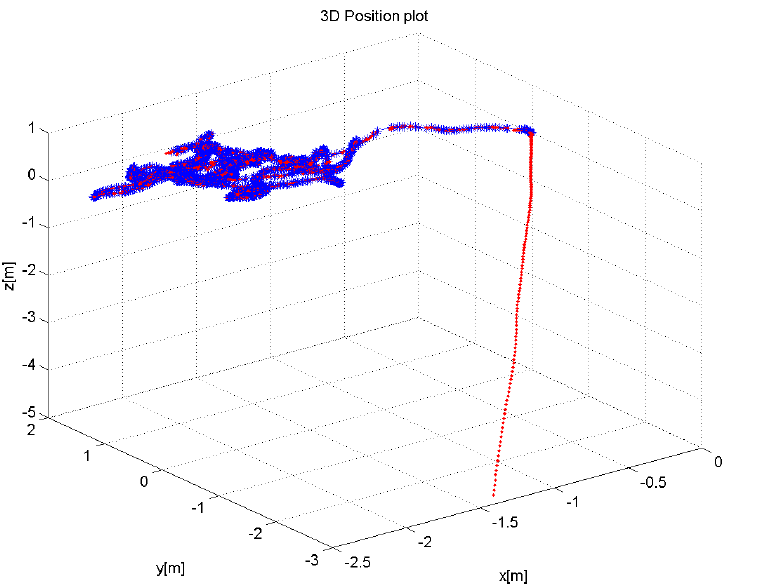
Figure 7. Estimated 3D flight trajectory of the hexacopter for outdoor sequence (in blue) and inertial output (in red). The Kinect sensor was activated after the take-off, showing some drift in the inertial output.